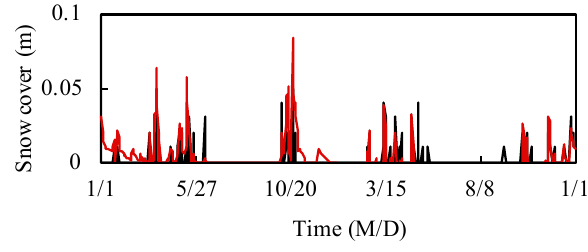
Figure 2. Comparison between simulated (red solid line) and mea- sured (black solid line) results for the thickness of snow cover from Figure 2: Comparison between simulated (red solid line) and measured (black solid line) results for the 2005 to 2006. thickness of snow cover from 2005 to 2006.